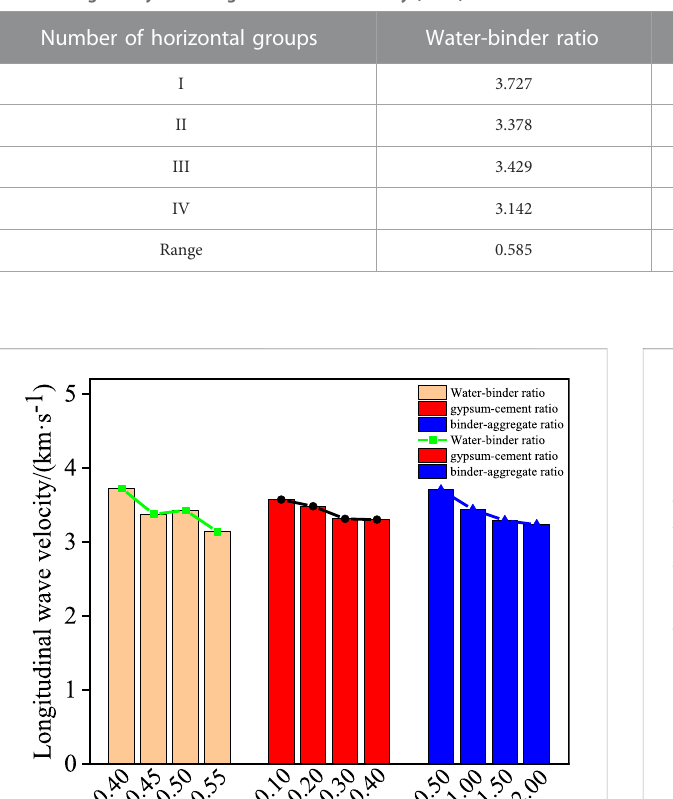
FIGURE 9 Sensitivity analysis of deformation